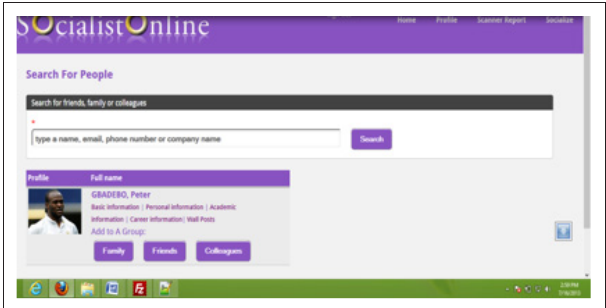
FIGURE 2: Screenshot for customised